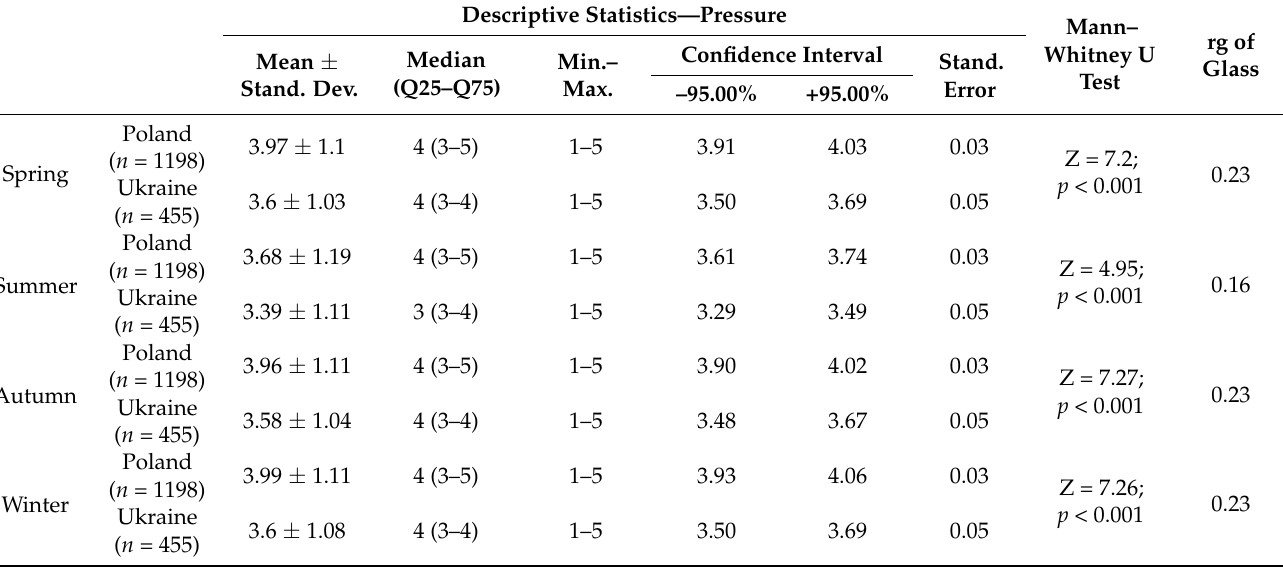
Mann– rg of Whitney U Test